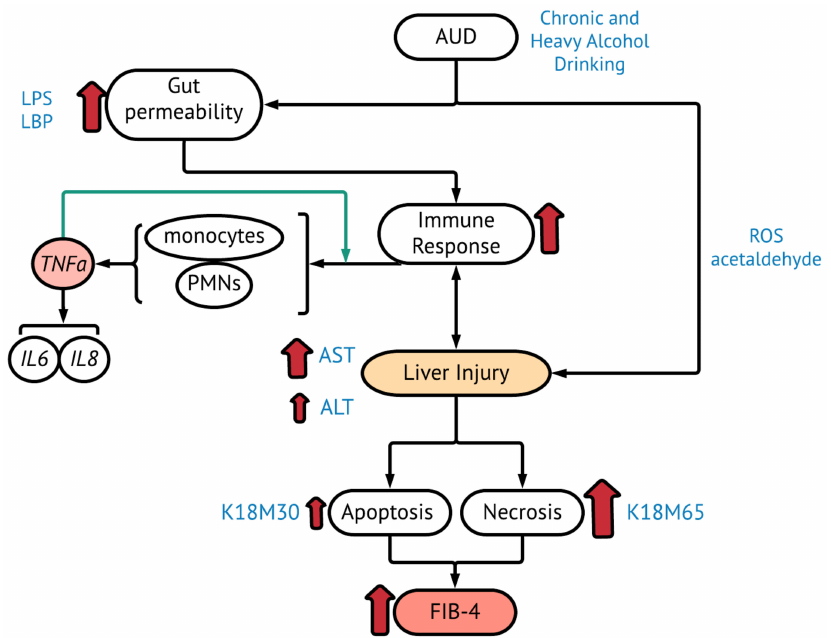
Figure 1. Model to illustrate the mechanism of the development of Early-Stage ALD from AUD; and the mediating inflammatory cytokines, hepatocyte death biomarkers, and liver injury markers. Cytokeratin 18 (K18) is an intermediate filament protein that is present in simple epithelial tissues and constitutes part of the hepatocyte cytoskeleton [4,5]. Soluble K18 is released from dying cells and can be used in detecting overall cell death (due to apoptosis and necrosis) in the liver [6]. K18 is passively released during necrosis, while during apoptosis K18 is cleaved by caspases [6]. The cleaved form is referred to as K18M30 while the whole protein is referred to as K18M65 [6]. IL-8 expression is regulated by TNF- α [7] and this cytokine response directly contributes to the induction of